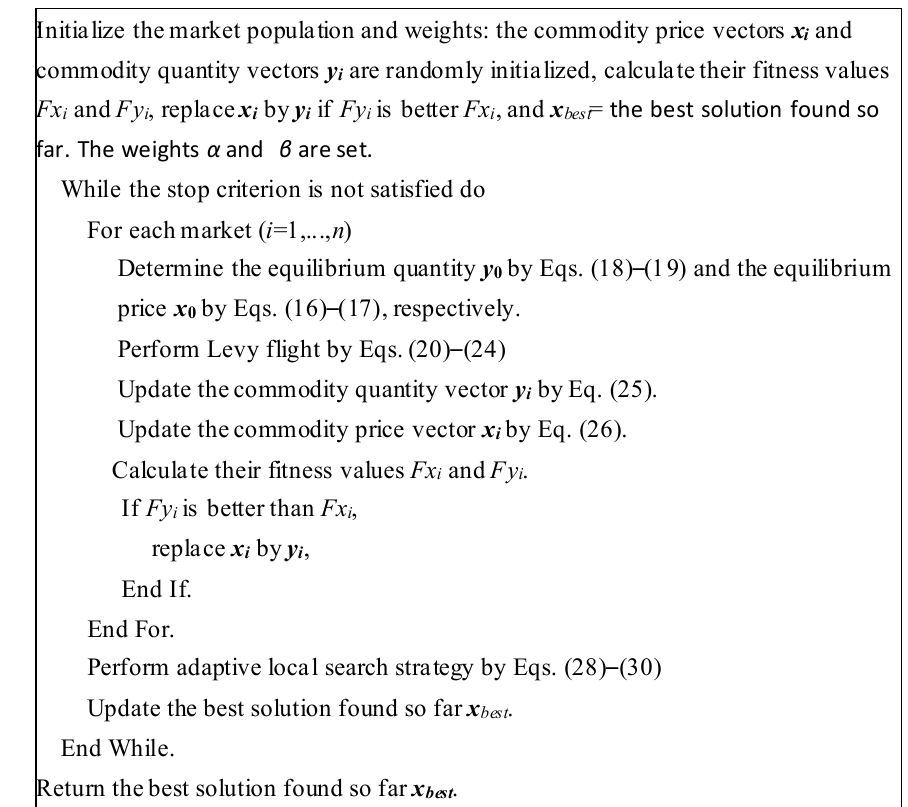
Figure 2. Pseudocode of ESDO algorithm.